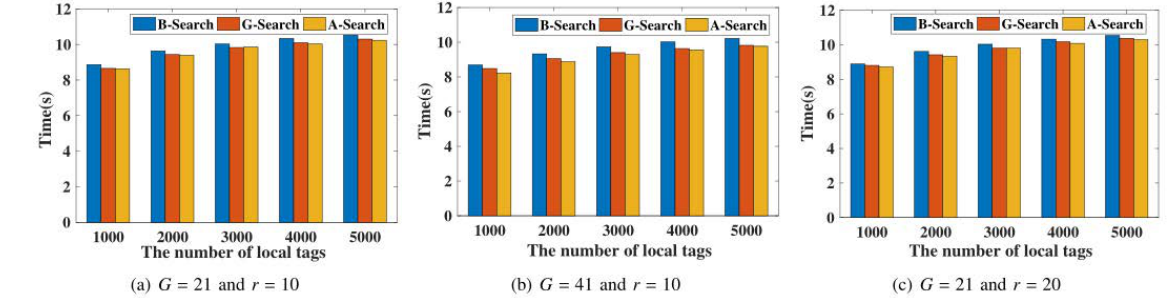
Figure 5. The time efficiency of each protocol under different numbers of local tags.